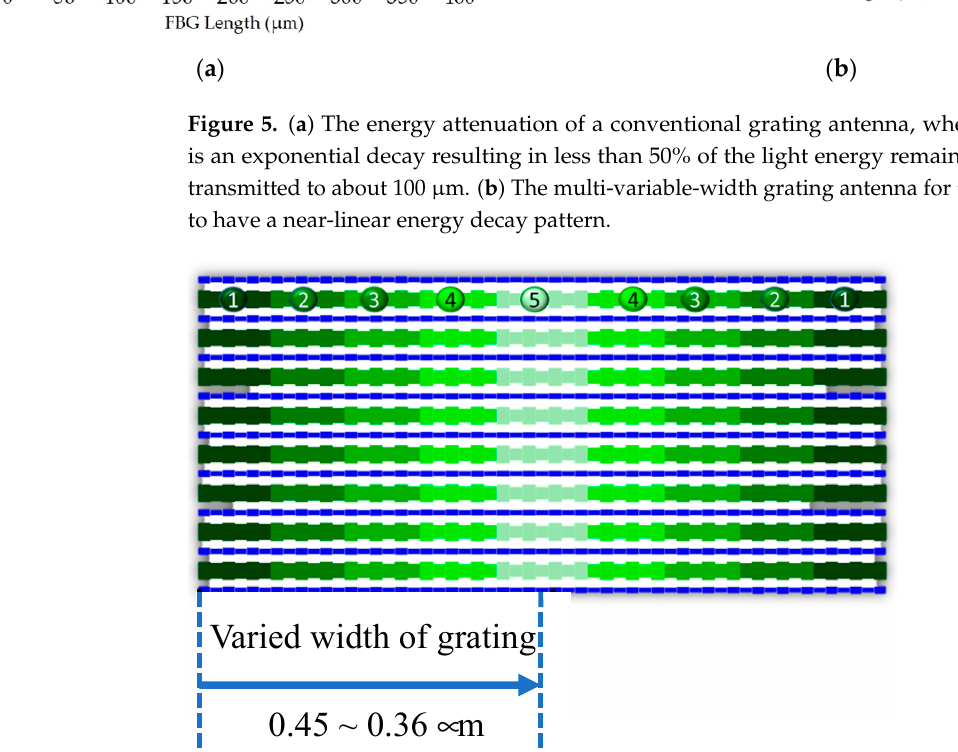
Figure 6. Input OPA grating antenna structure in the bi-directional FBG built with SR . Table 1. The design parameters for the FBG built with the SR.